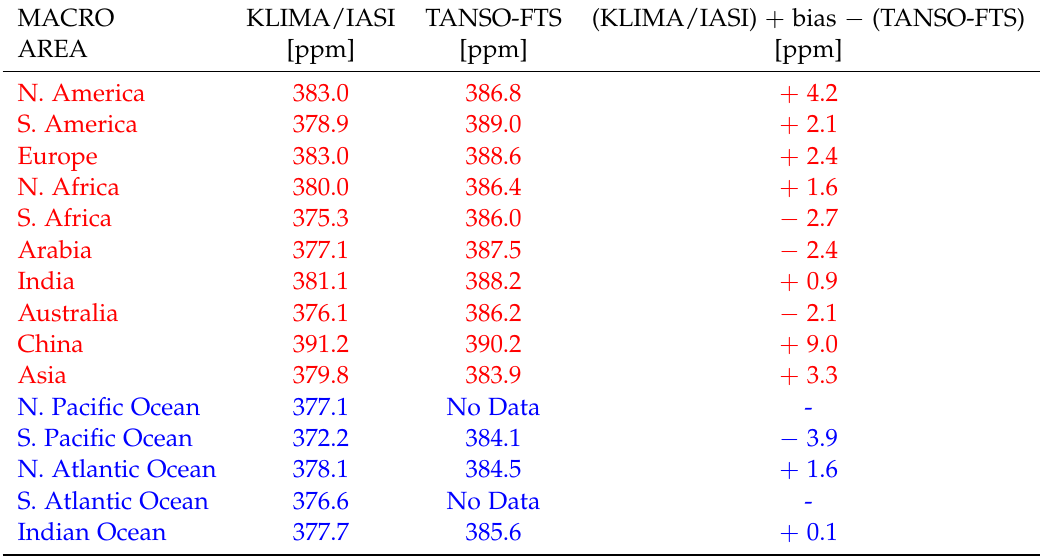
Table 1: Comparison of the retrieved annual average of XCO 2 [ppm] in selected homogeneous macro areas. In red are reported macro areas over land, in blue are reported macro areas over